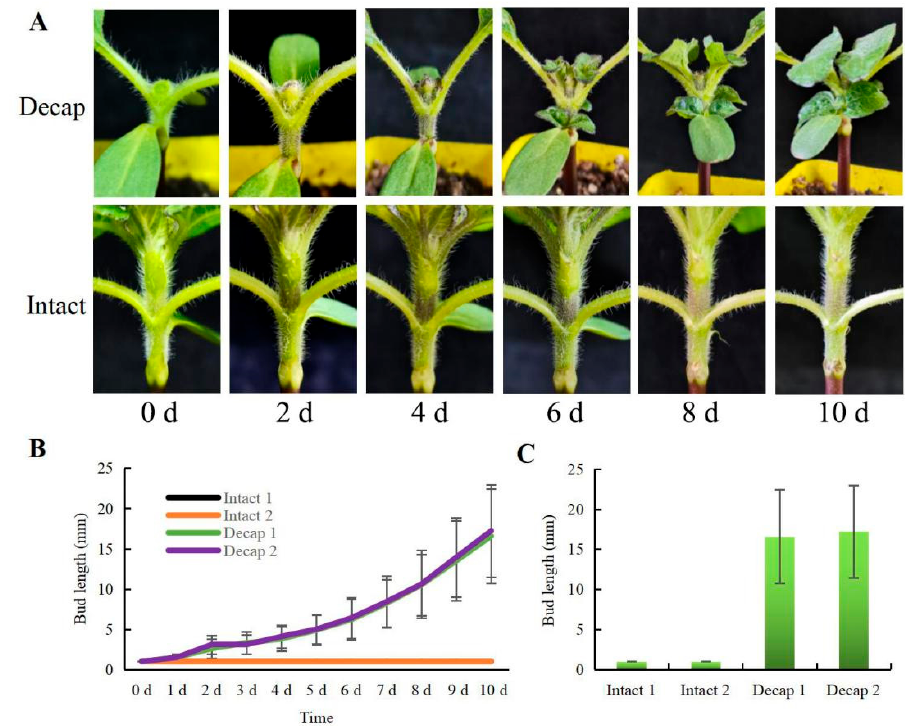
Figure 1. Effects of decapitation on the bud growth of sunflowers. ( A ) Sunflower buds after decapitation and the control group (Intact). ( B ) The bud length of sunflowers on different days after decapitation ( n = 12). ( C ) The bud length of the sunflowers on the 10th day ( n = 12). Values are means ± SE for ( B , C ).